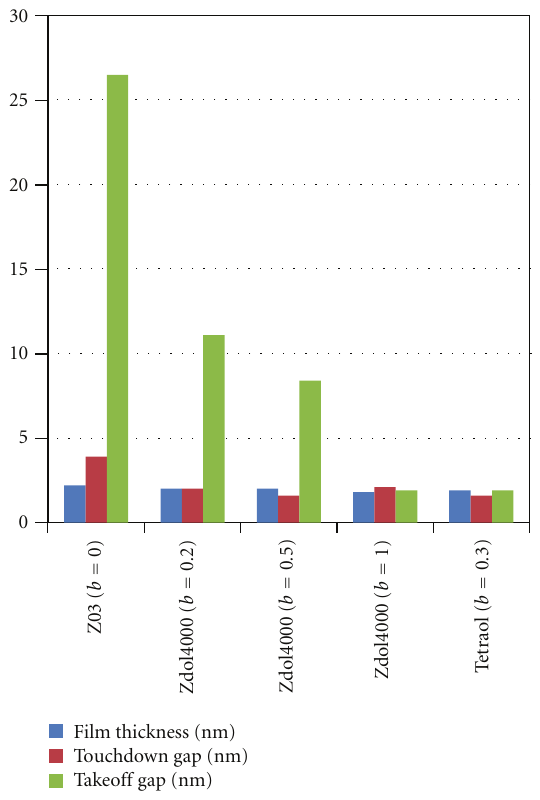
Figure 12: Experimental results of the touchdown gaps in the approaching process and takeo ff gap in the separating process.